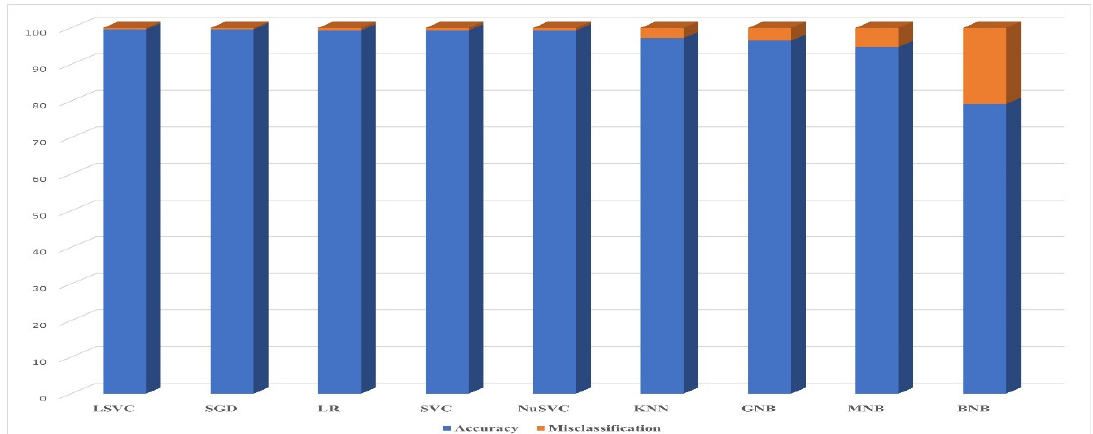
Fig. 6: Overall Accuracy vs Misclassification Report